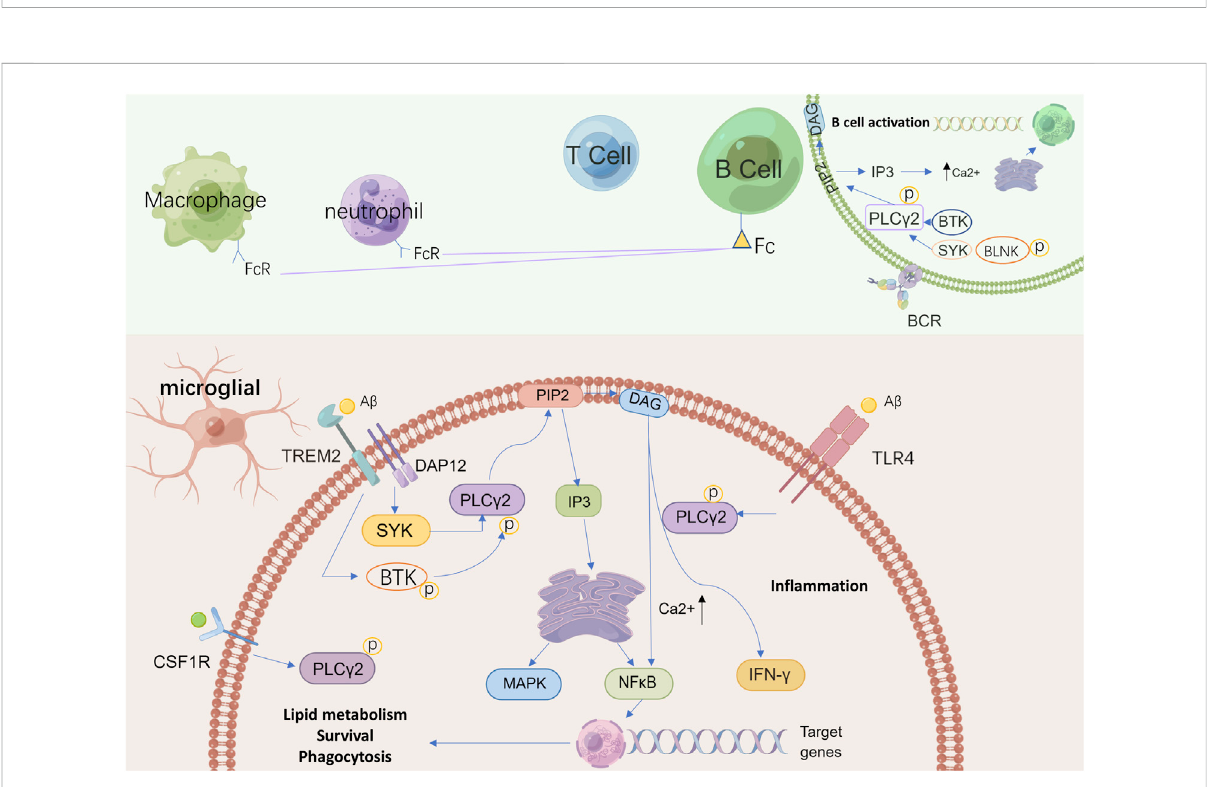
FIGURE 2 AschematicviewofpossiblepathwaysrelatedtoPLC γ 2inmicrogliaandotherimmunecells.PLC γ 2belongstoagroupofintracellularenzymes that cleave the membrane phospholipid PIP2 to DAG and IP3, resulting in increased calcium signaling. In absence of activating signals, PLC γ 2 is neitherrecruitedtothemembraneoractivatedbutinsteadmaintainedinitsautoinhibitedforminthecytoplasm.Inthebrain,PLC γ 2ispredominantly expressed by microglia. In microglia, PLC γ 2 can be activated downstream of TREM2 – DAP12 via interaction with SYK to promote bene fi cial microglial functionality, while also signaling downstream of TLR4 signaling upon ligand stimulation to induce an in fl ammatory response. The activation of PLC γ 2 fi nally supports lipid metabolism, phagocytosis, and survival. PLC γ 2 activation also leadsto BCR signaling, including activation of SYK, BTK, and BLNK with increased calcium signaling. This process affects B cell development and increases the production of neutrophils and macrophages. In these immune cells, as a downstream protein in Fc receptor signaling, PLC γ 2 regulates calcium-dependent functions to support immune and in fl ammatory responses. PIP2: phosphatidylinositol-4,5-bisphosphate; DAG: diacylglycerol; IP3: inositol 1,4,5 trisphosphate;